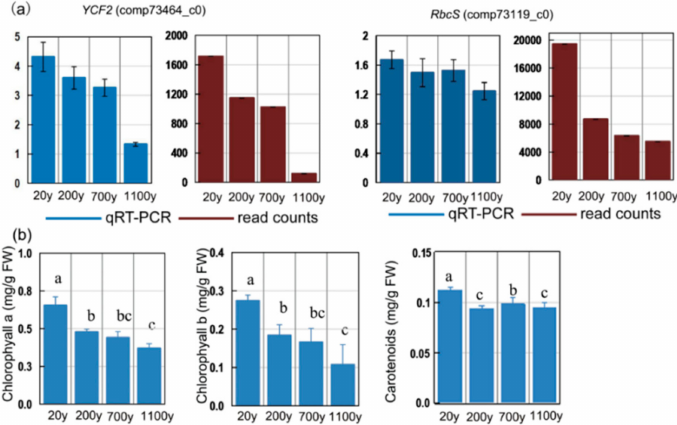
Figure 10. ( a ) Expression patterns of photosynthesis-related unigenes in Platycladus orientalis leaves. Verification of four selected DEGs by RT-qPCR. Blue and red columns correspond to the RT-qPCR and RNA-seq results, respectively. The α TUB gene was used as the internal control. ( b ) chlorophyll a and b and carotenoids contents. All data points are means ± SD ( n = 3). Means in each column followed by di ff erent lowercase letters are significantly di ff erent ( p <